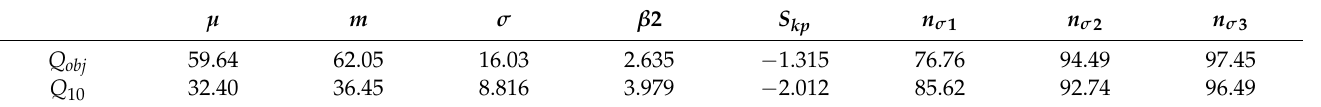
Table 3. Descriptive statistics for the distribution of the annual number of days with low flow for Q obj and Q 10 methods: µ —mean [m 3 /s], m —median [m 3 /s], σ —standard deviation [m 3 /s], β 2—kurtosis,